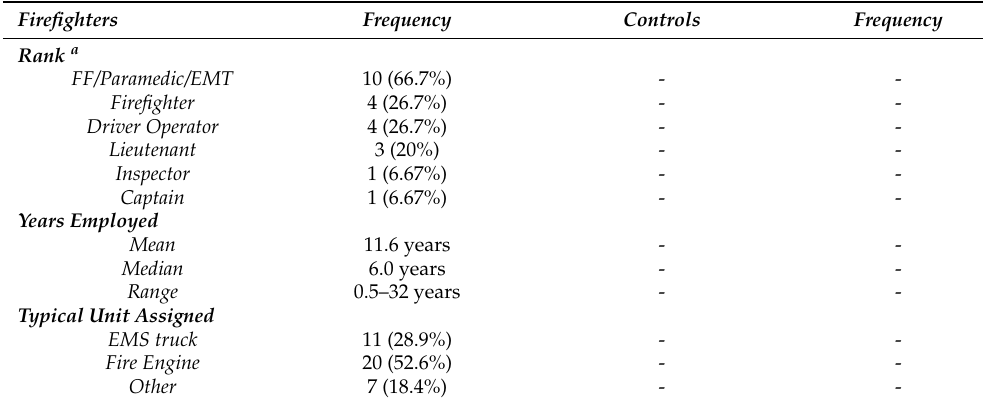
Table 4. Firefighter cohort